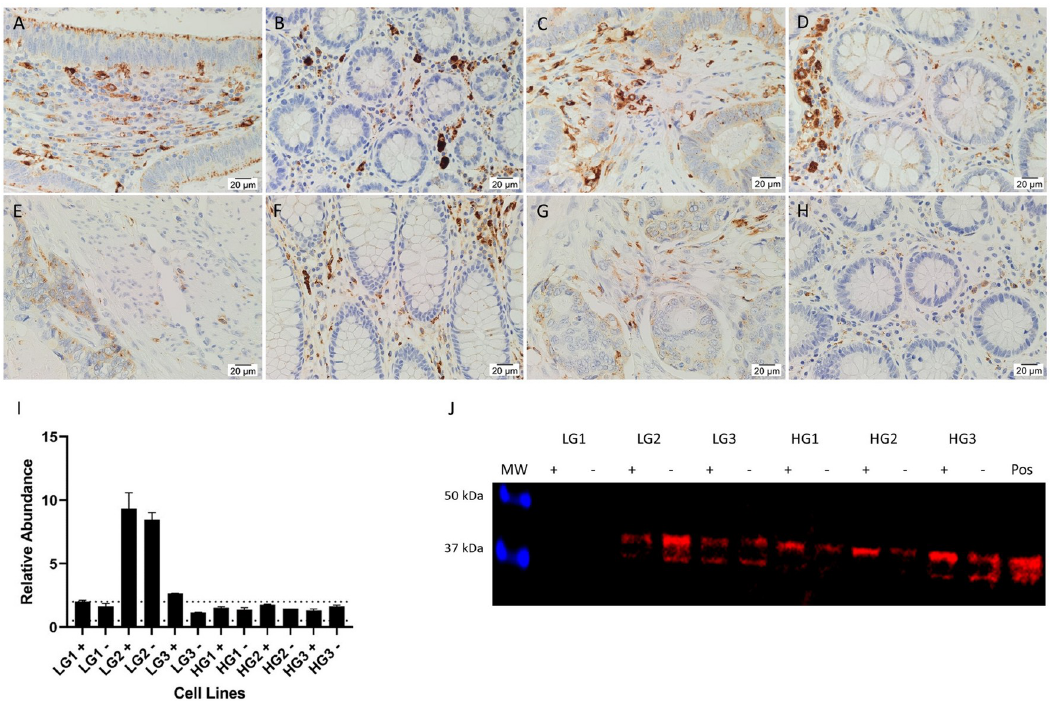
Fig 5. Expression of cathepsin D. Representative IHC stained images of CTSD (brown), including 2 LGCA) samples (A, C) and their patient-match NC tissues (B, D), and 2 HGCA samples (E, G) and their patient-matched NC tissues (F, H). Nuclei were counterstained with hematoxylin (A-H, blue); original magnification: 400x. CTSD mRNA expression levels were measured by RT- qPCR (I) in 3 LGCA and 3 HGCA primary cell lines that were sorted into EpCAM High (+) and EpCAM Low (-) subpopulations, and the average mRNA abundance from triplicate values relative to a pool of NC tissues are displayed with error bars representing standard deviation. CTSD protein expression by these cell lines was detected by WB (J; 43 kDa and 46 kDa); positive control = HepG2 cells. Adapted from [38] under a CC BY license, with permission from Munro MJ et al . 2021.